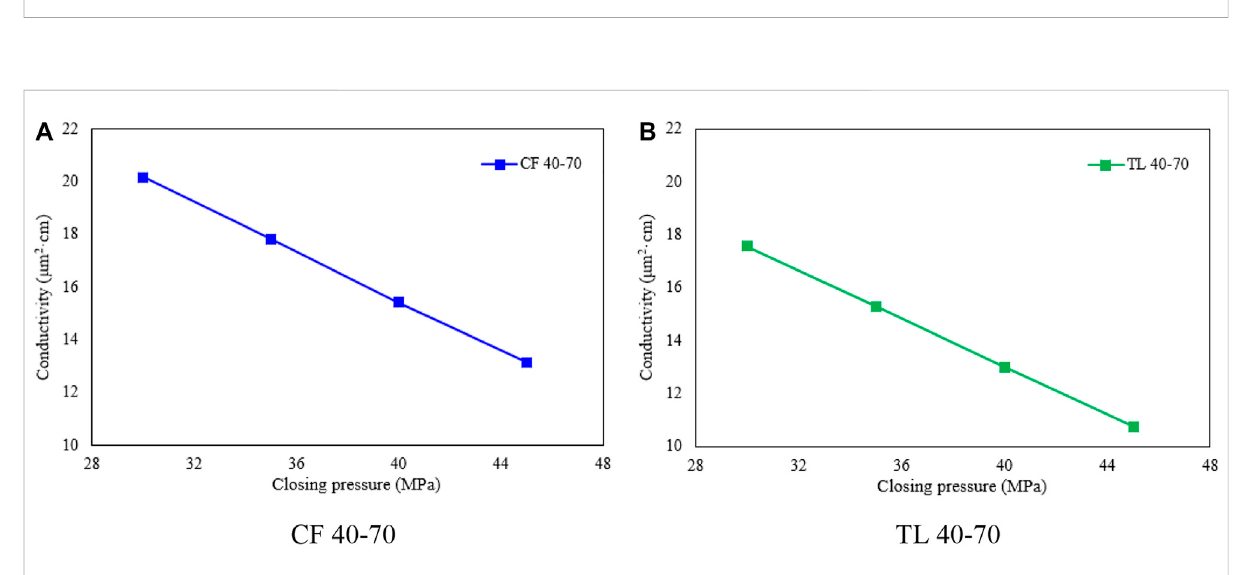
FIGURE 7 The conductivity of 40 – 70 mesh proppant varies with the closing